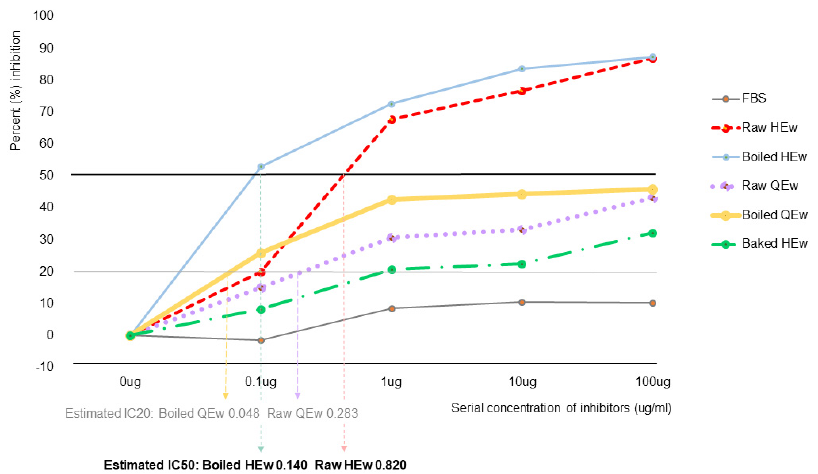
Figure 2. IgE-enzyme-linked immunosorbent assay-inhibition test with pooled sera using inhibitors. QEw, quail egg white; HEw, hen’s egg white.